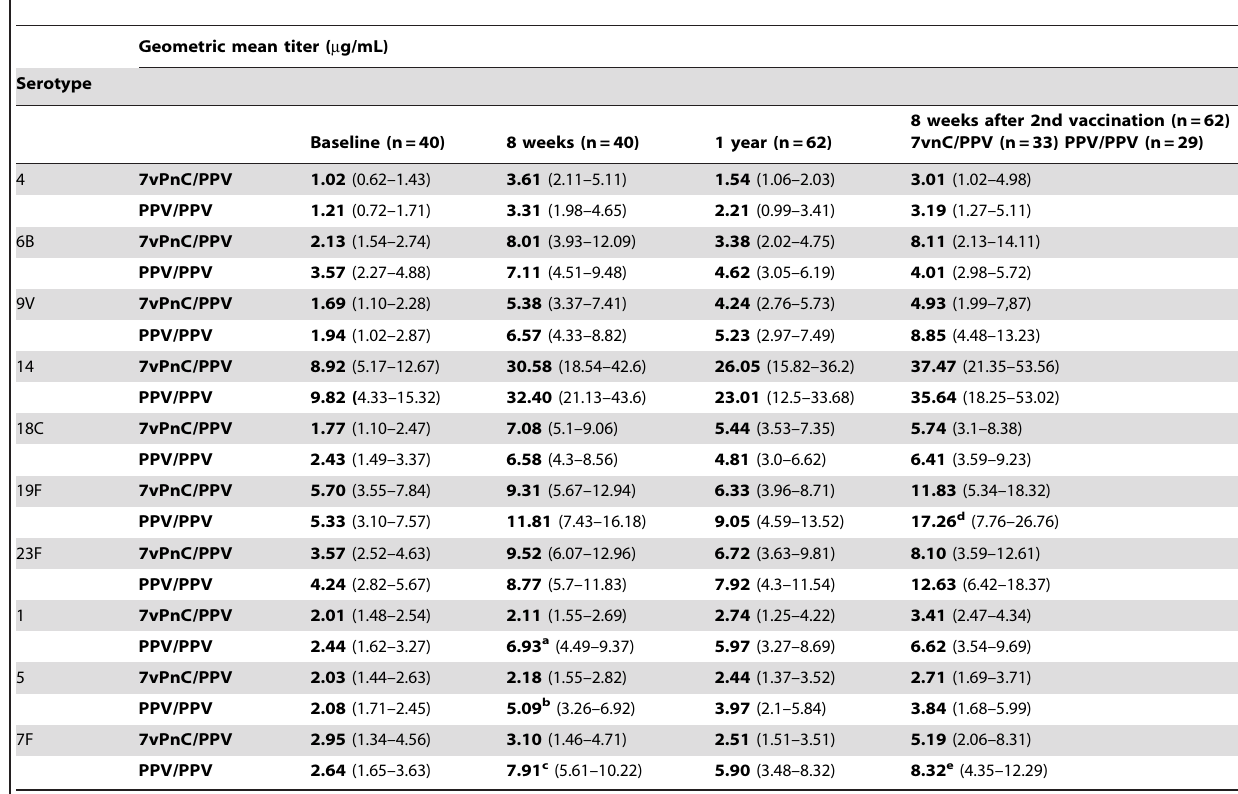
Table 3. Geometric mean concentrations (95% CI), expressed as m g/mL, of serotype-specific anti-pneumococcal IgG serum antibody at baseline, 8 weeks, and 1 year after vaccination with 7vPnC and PPV, and 8 weeks after revaccination with PPV.